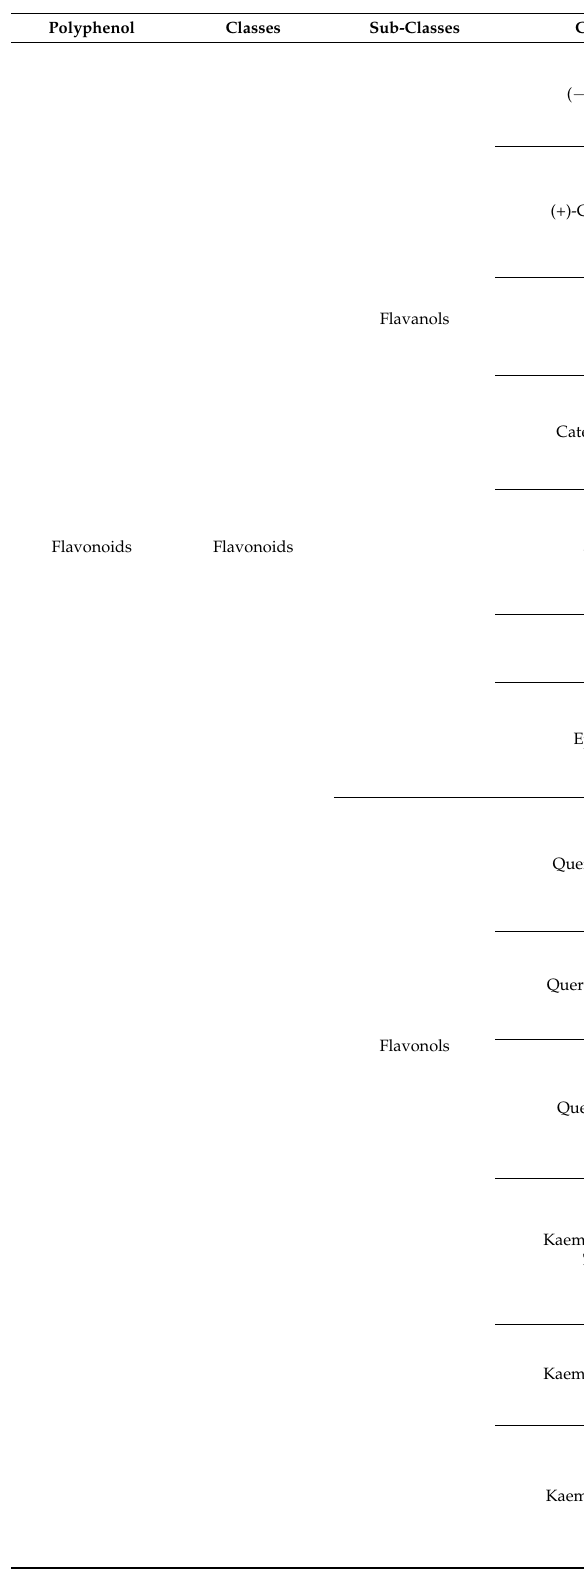
Table 3. List of polyphenols in lentils ( Lens culinaris ) [30–37].